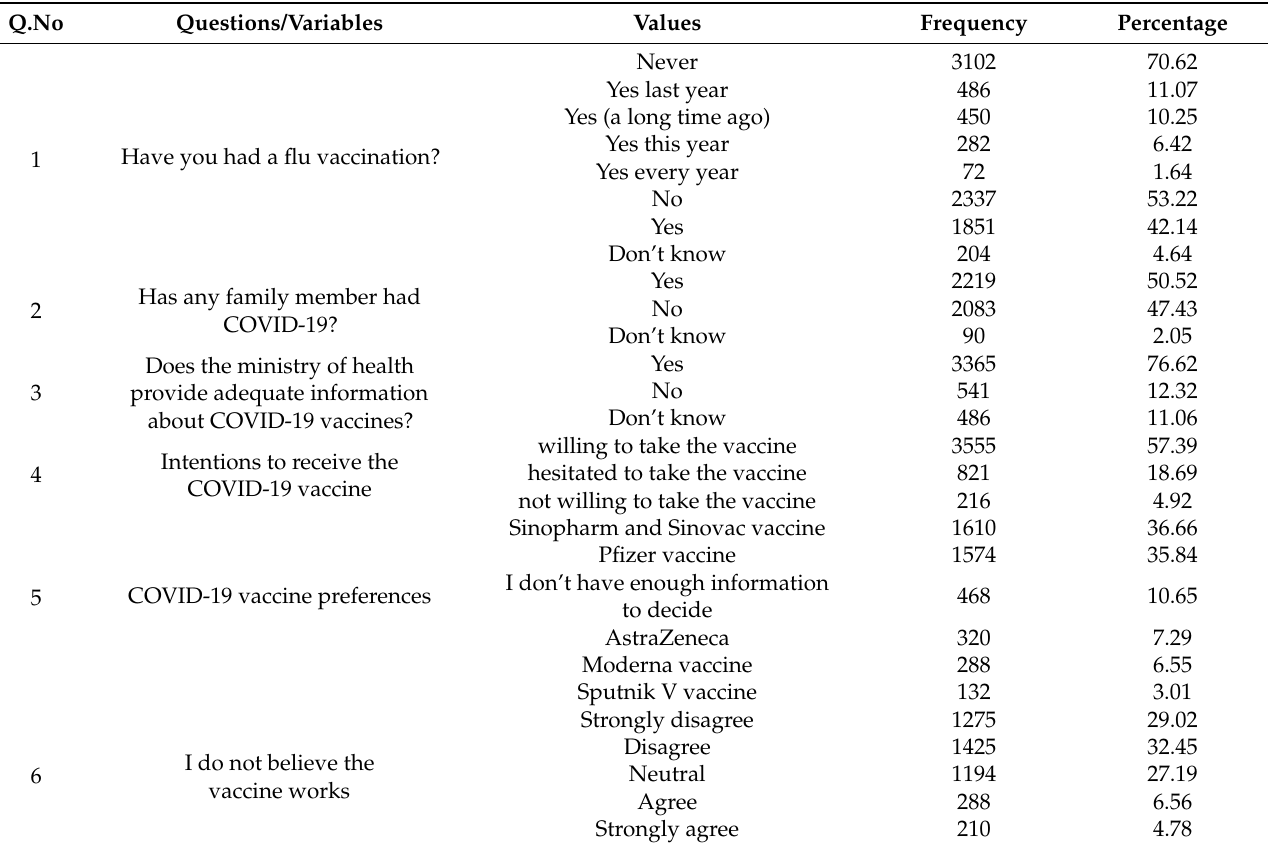
Table 2. The attitude toward COVID-19 vaccines among the general population ( n = 4392).